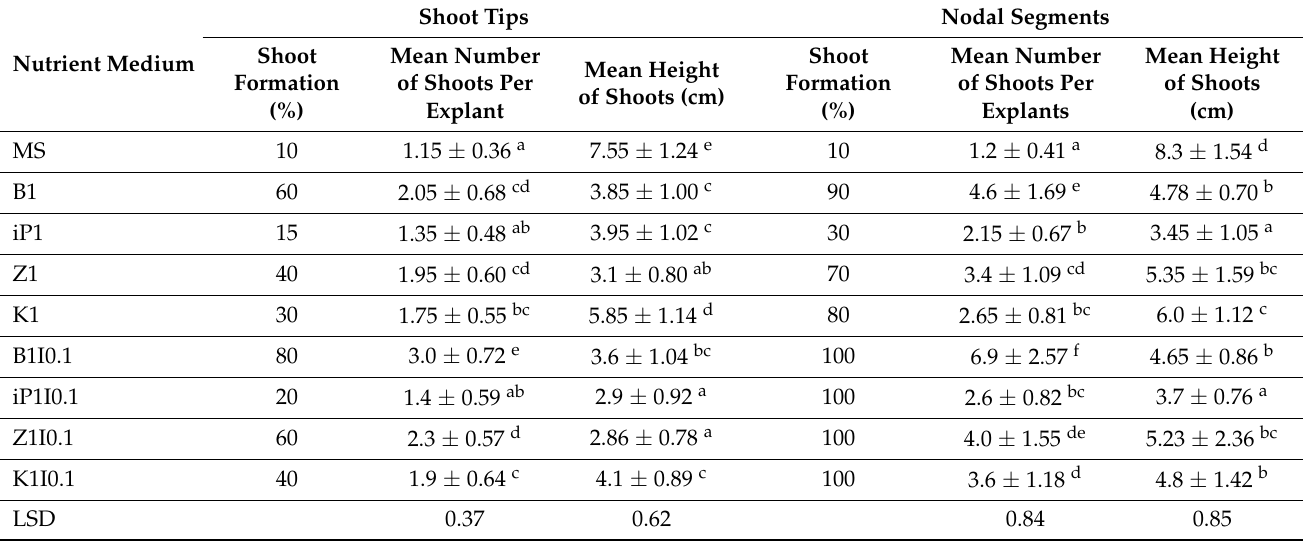
Table 1. Effect of plant growth regulators on micropropagation of Clinopodium vulgare —I st subculture.